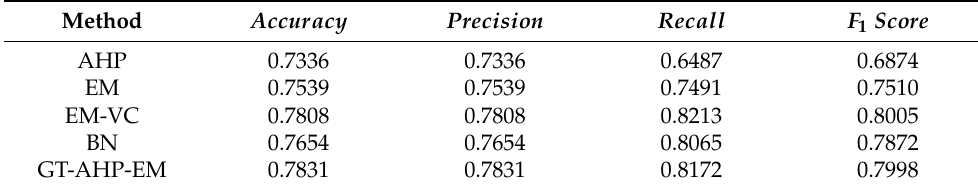
Table 12. Comparison of five methods of